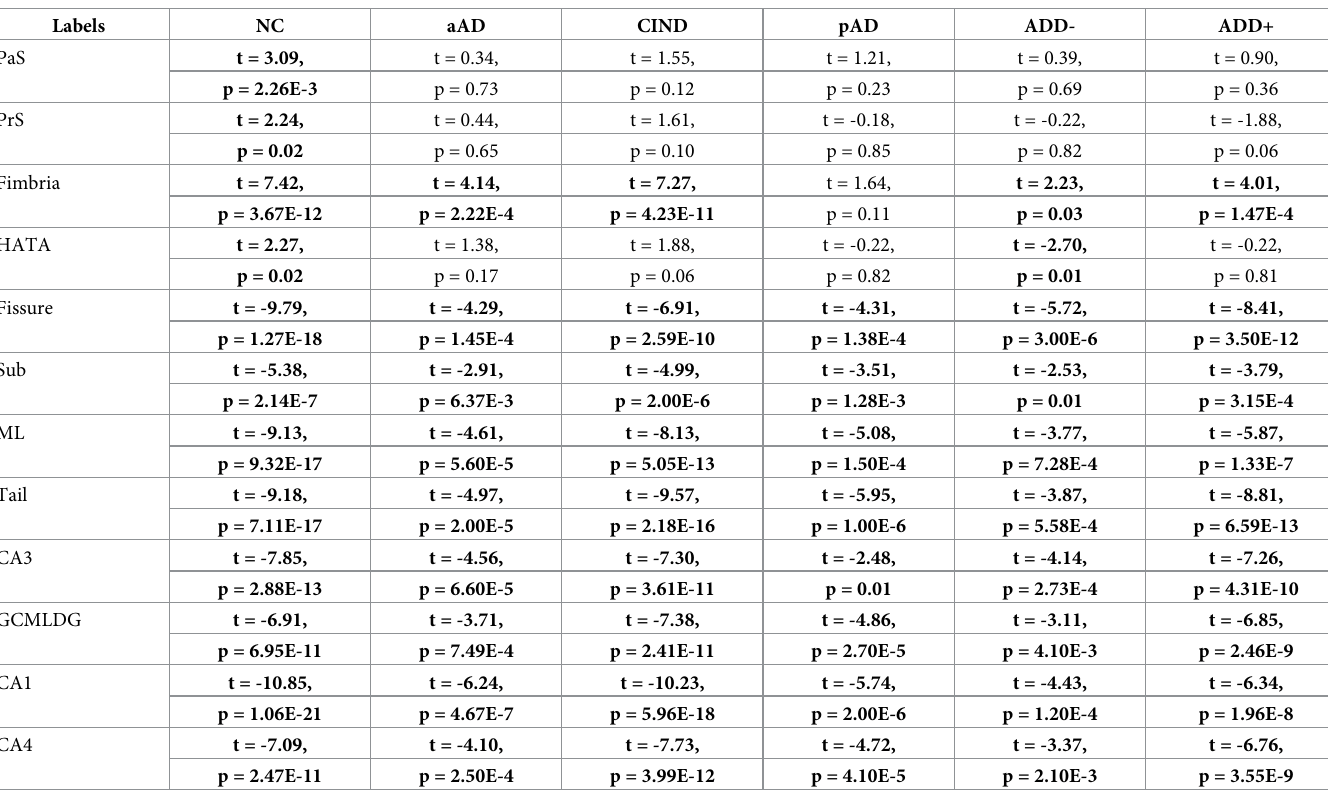
Table 4. Comparison of hemispheric differences using paired t-tests.